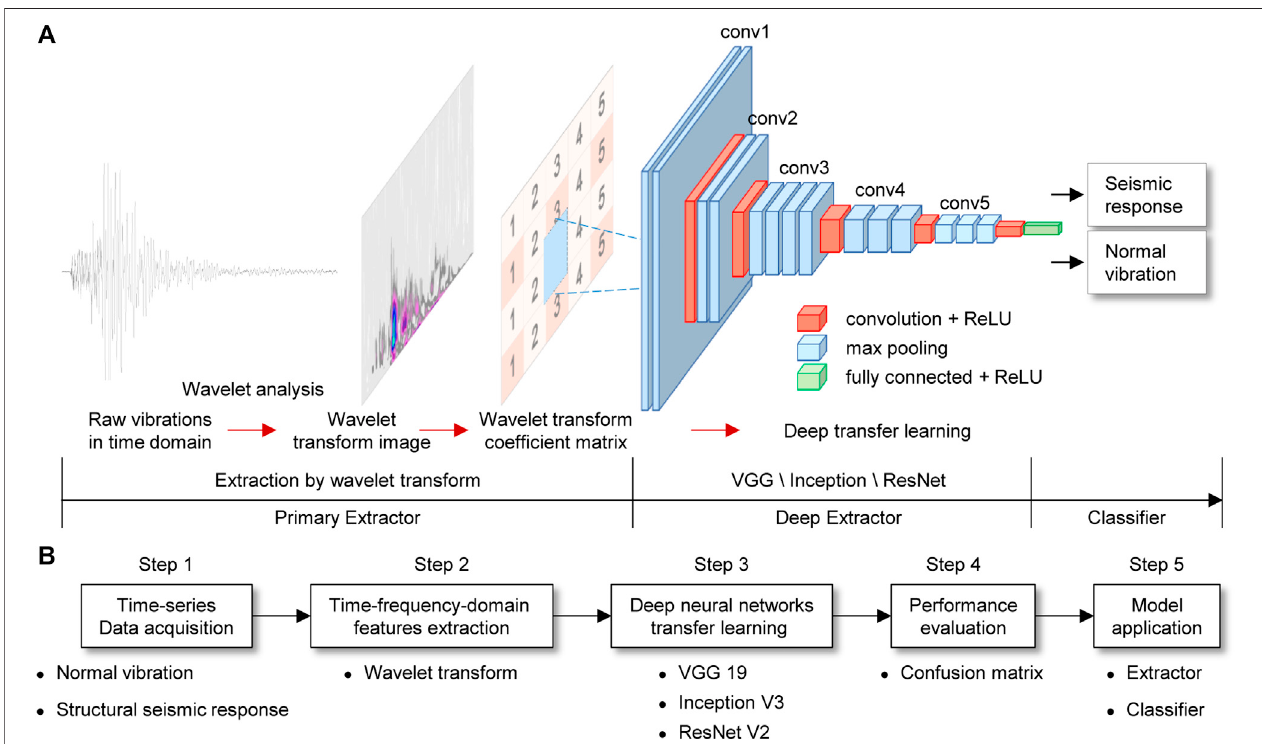
FIGURE 1 | Time – frequency characteristics and deep neural network-based vibration identi fi cation method: (A) structural seismic response identi fi cation method and (B) detailed implementation of proposed method.